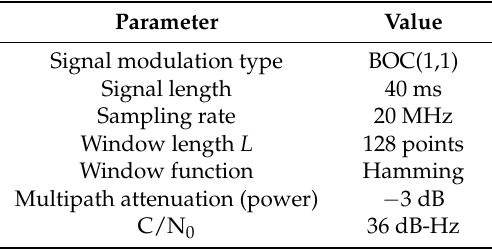
Table 1. Setting of Multipath Parameter Estimation.